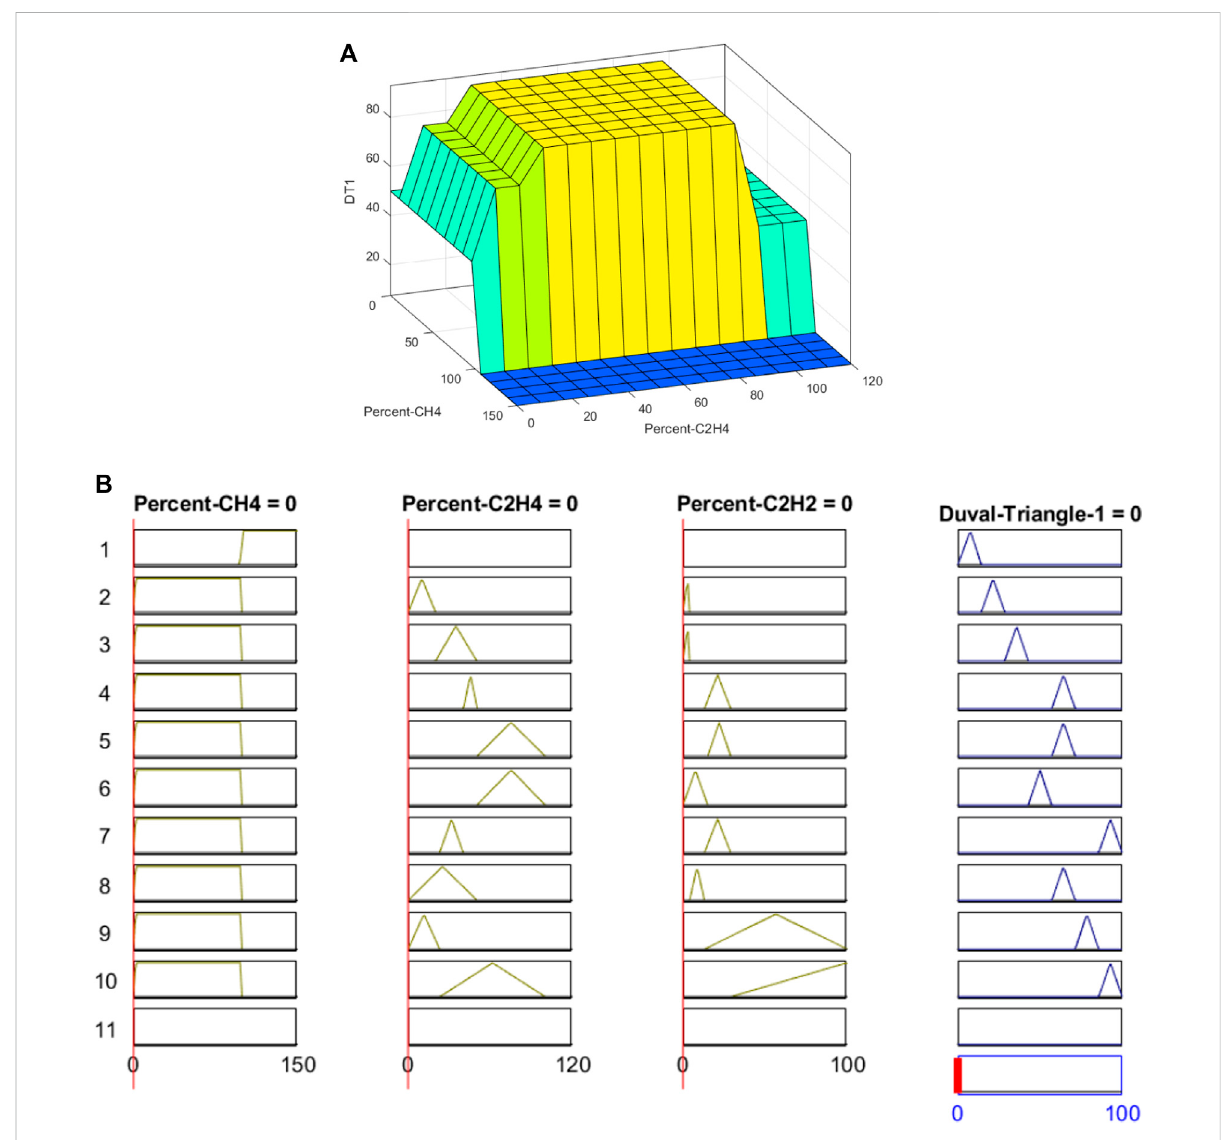
FIGURE 7 (A) Surface formed for Duval triangle 1. (B) Rules used in fuzzy sublogic for Duval triangle